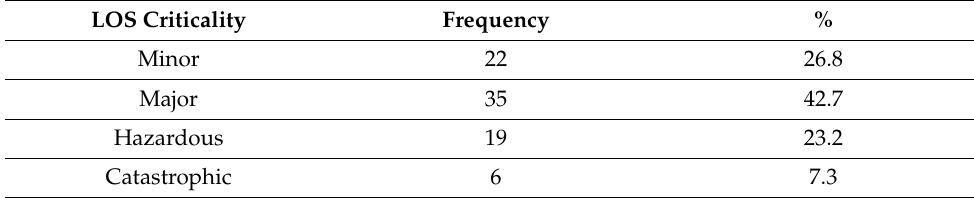
Table 5. Frequency distribution of the target node LOS Criticality variables. Table 5 . Frequency distribution of the target node LOS Criticality variables.